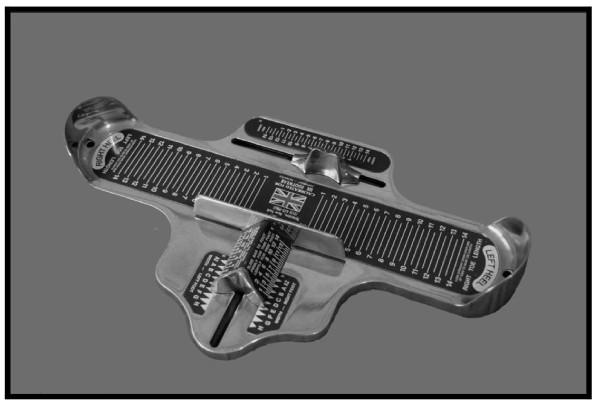
The Brannock® device.